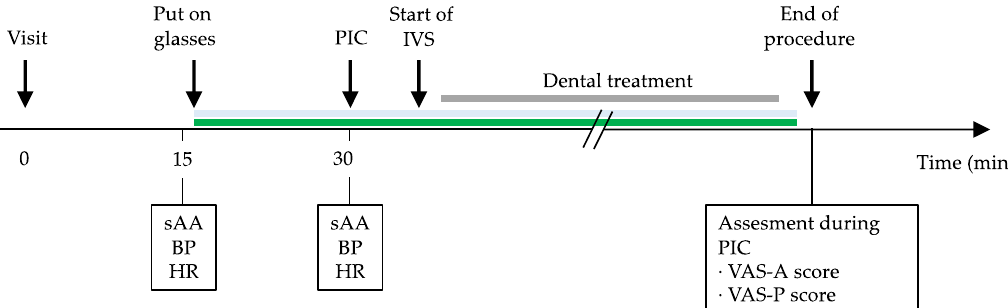
Figure 2. Study protocol. BP, blood pressure; HR, heart rate; PIC, peripheral intravenous cannulation; sAA, salivary alpha-amylase; VAS-A, visual analog scale for anxiety; VAS-P, visual analog scale for pain.